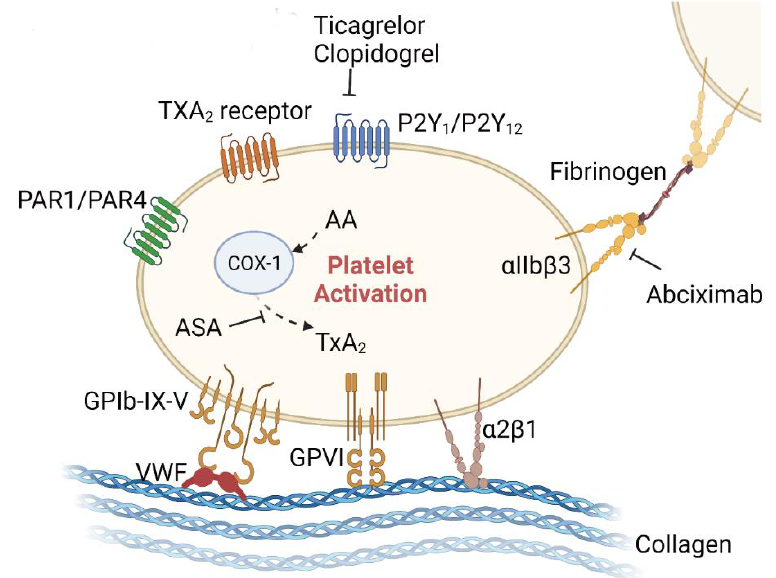
Figure 3. Anti-platelet therapies for AAA in the preclinical stage. Adhesion proteins/receptors on the surface of platelets that can bind to other cells or the extracellular matrix include the integrin family (e.g., α2β1, αIIbβ3), the immunoglobulin superfamily (e.g., GPVI), the leucinerich repeat family (e.g., GPIb-IX-V complex), the G-proteincoupled receptors (PAR-1, PAR-4, P2Y1, P2Y12, and TxA2), and the C-type lectin receptor family (e.g., P-selectin). Some of these receptors are involved in the progression of AAA, while others remain unexplored. Aspirin irreversibly inhibits platelet COX-1, blocks TxA2 production in platelets, and decreases platelet aggregation. P2Y12 receptors are crucial for the platelet activation potentiated by agonists, including ADP, collagen, vWF, and TxA2. P2Y12 receptor antagonists, such as clopidogrel and ticagrelor, inhibit platelet activation by irreversibly binding to P2Y12 receptors and blocking the ADP-dependent pathway. Integrin α IIb β 3 is expressed at high levels in platelets. Upon agonist stimulation, it switches from a low- to high-affinity state for fibrinogen and other ligands, leading to integrin clustering and activating outside-in signaling, which drives platelet aggregation and thrombus consolidation. The illustration elements are from Biorender (https://biorender.com/) (accessed on 30 June 2022; Agreement number: